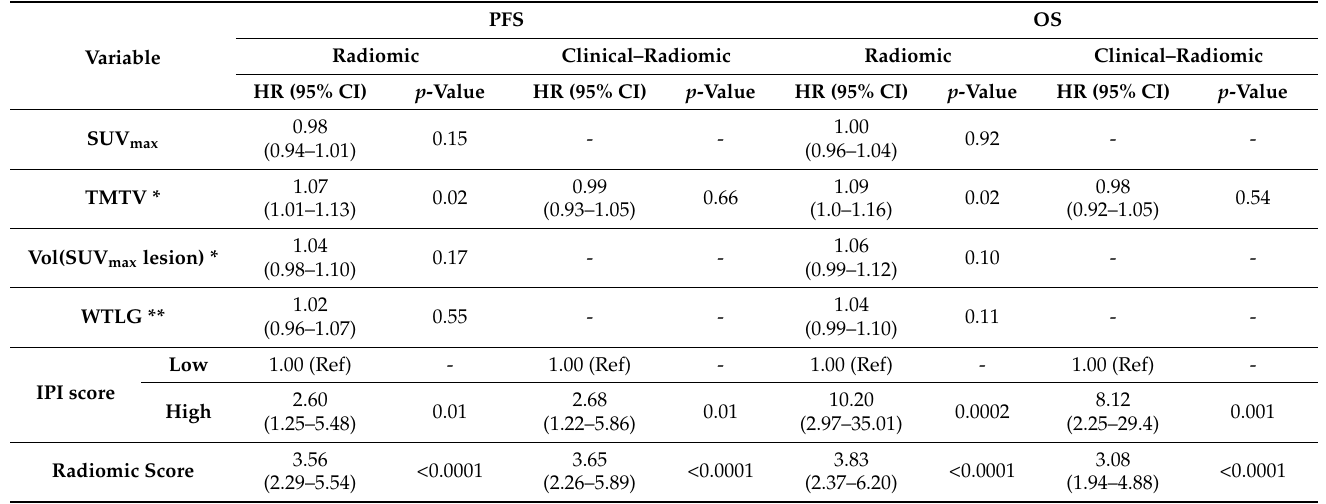
Table 3. Univariate and multivariable hazard ratio (HR) with 95% confidence intervals (CI) for the association of continuous variables with progression-free survival (PFS) and overall survival (OS).